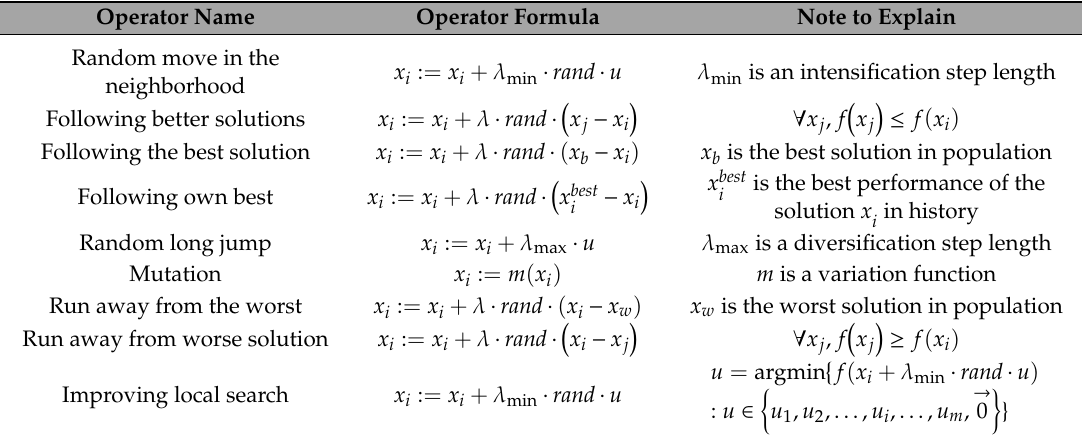
Table 1. Some widely and recently used